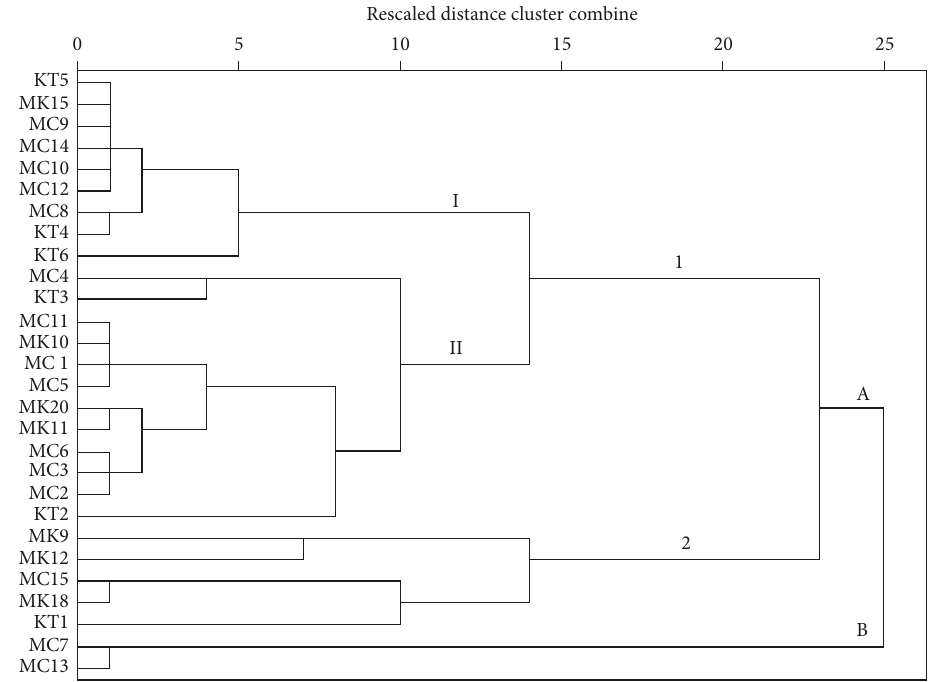
Figure3:DendrogramshowingthephenotypicrelationshipsgeneratedamongrhizobiaisolatesfromagriculturalsoilsoflowereasternKenya. The UPGMA method was used for the cluster analysis of seven phenotypic characteristics (color, form, size, margin, elevation, growth rate, and